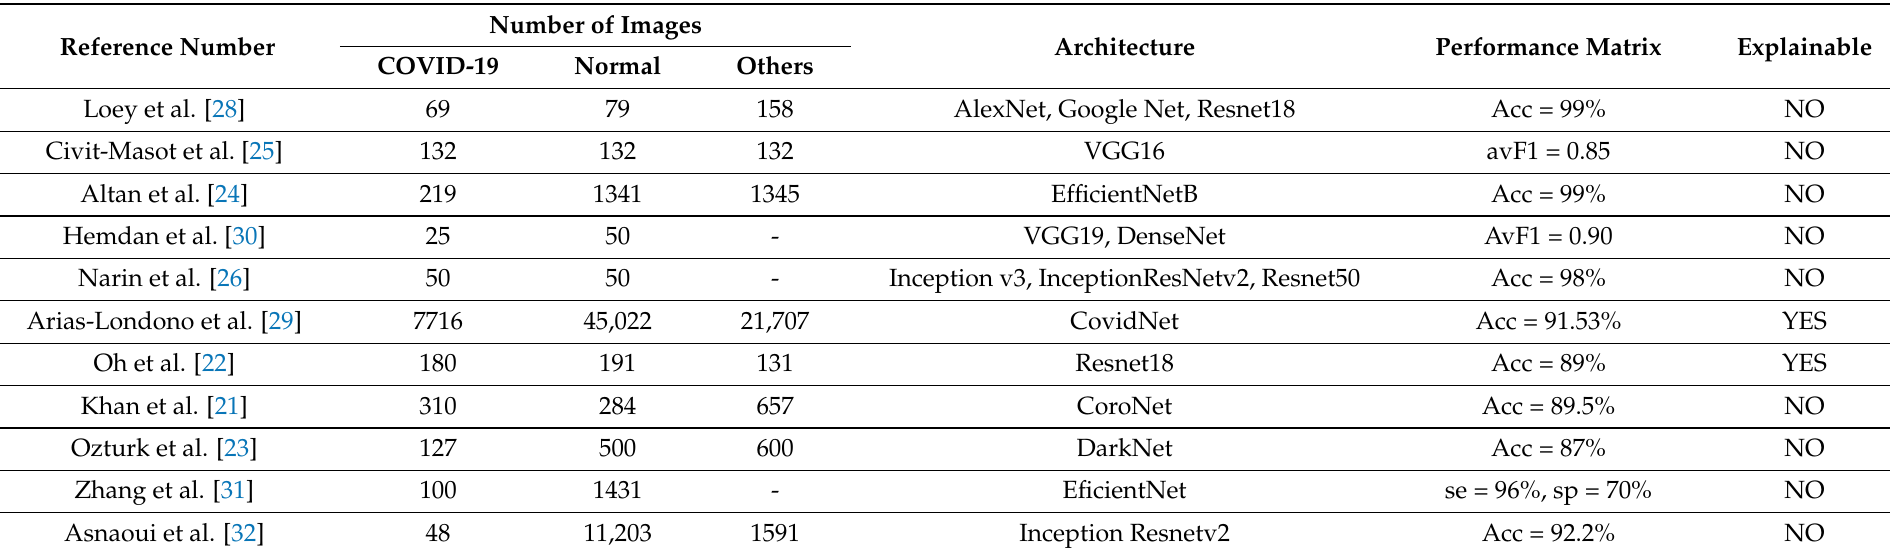
Table 1. Overview of the existing related studies (Here, Acc = Accuracy, avF1 = Average F1-score, Se = Sensitivity, SP =